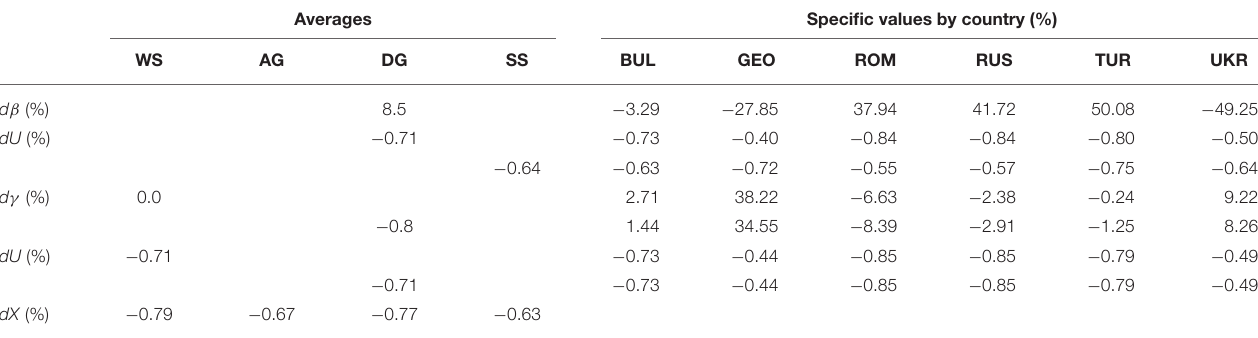
TABLE 10 | Black Sea: non-cooperative solutions. Averages Specific values by country